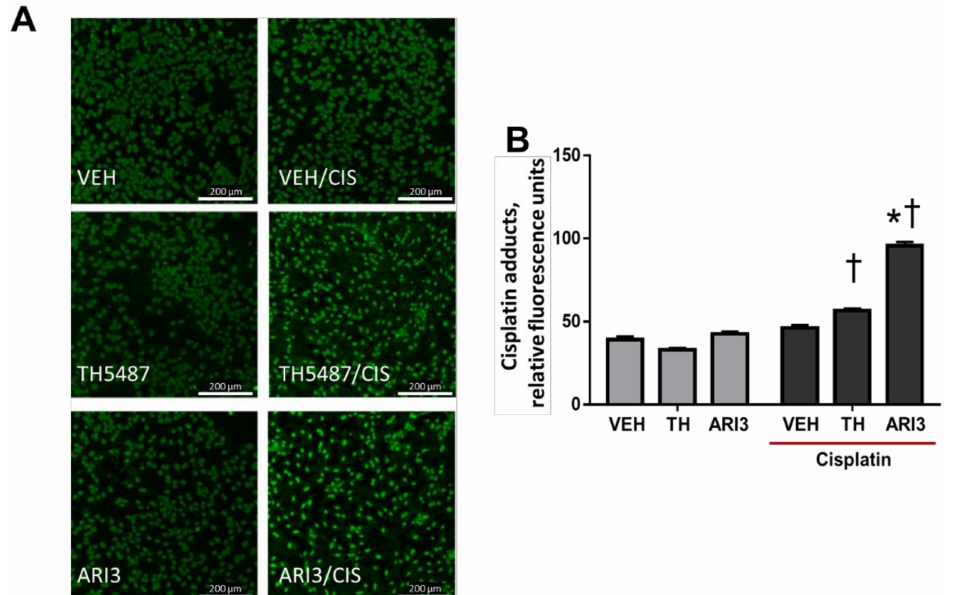
Figure 4. Effects of cisplatin and base excision repair inhibitors on cisplatin adduct levels in cells adjacent to sensory neurons. ( A ) Representative immunostaining for cisplatin adducts (green) in sensory neuron cultures. The original magnification was × 20. Scale bar represents 200 µ m. ( B ) Quantitative analysis of the integrated density of adduct staining within PGP9.5+ regions of the image field, acquired as relative fluorescence units using Cytation5 software. † p < 0.0001 comparing TH/CIS and ARI3/CIS to TH/VEH and ARI3/VEH, respectively, * p < 0.0001 comparing VEH/CIS to ARI3/CIS; two-way ANOVA with Tukey’s